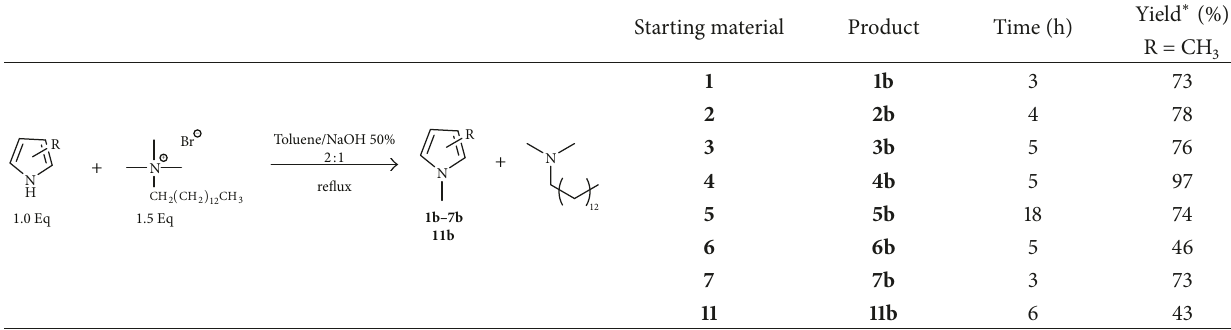
∗ Yields refer to chromatographically pure isolated